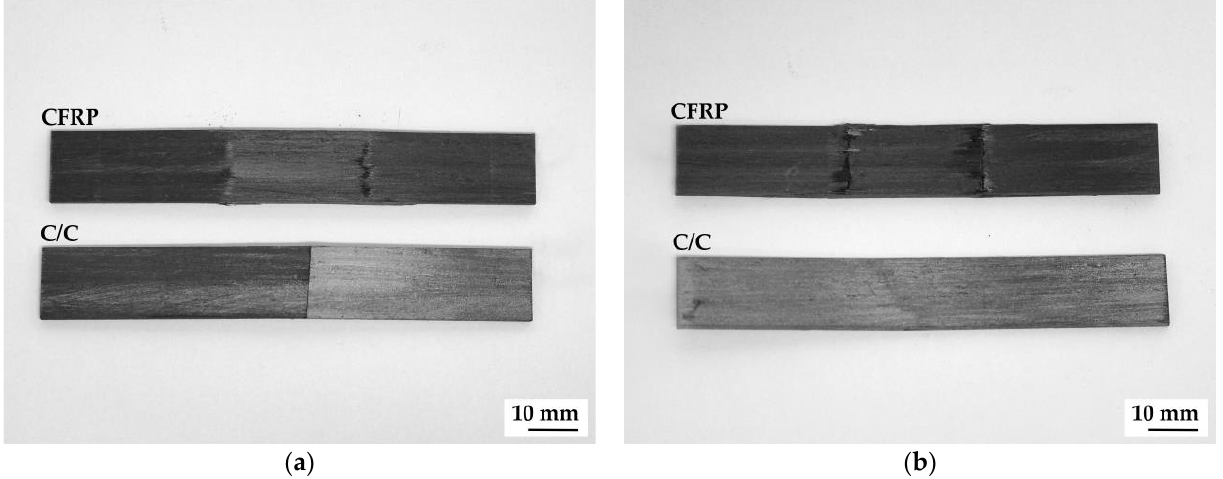
Figure 10. Macro images of fractured flexural specimens of the CFRP and C/C composites: ( a ) tensile-loaded side; ( b ) compression-loaded side.